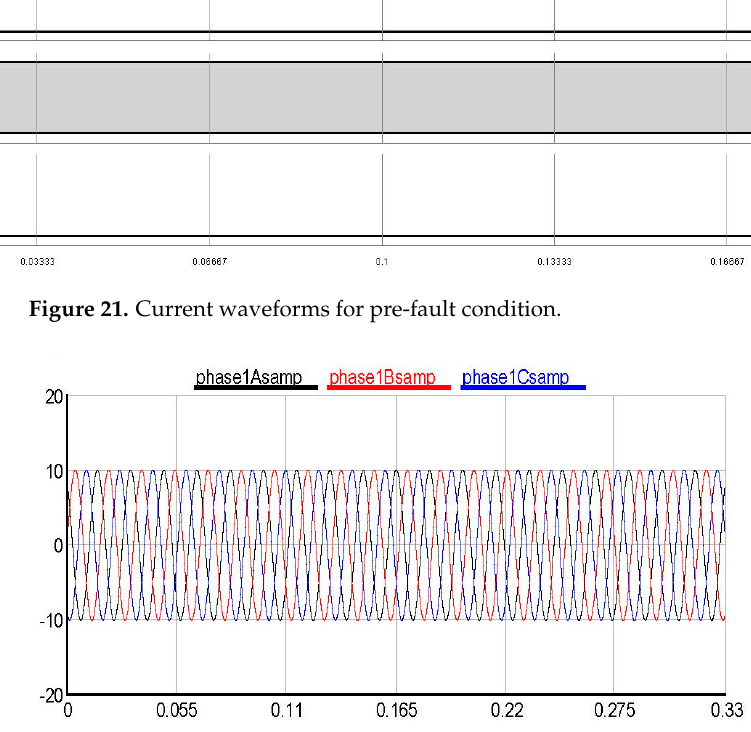
Figure 22. Voltage at bus 1 preceding the